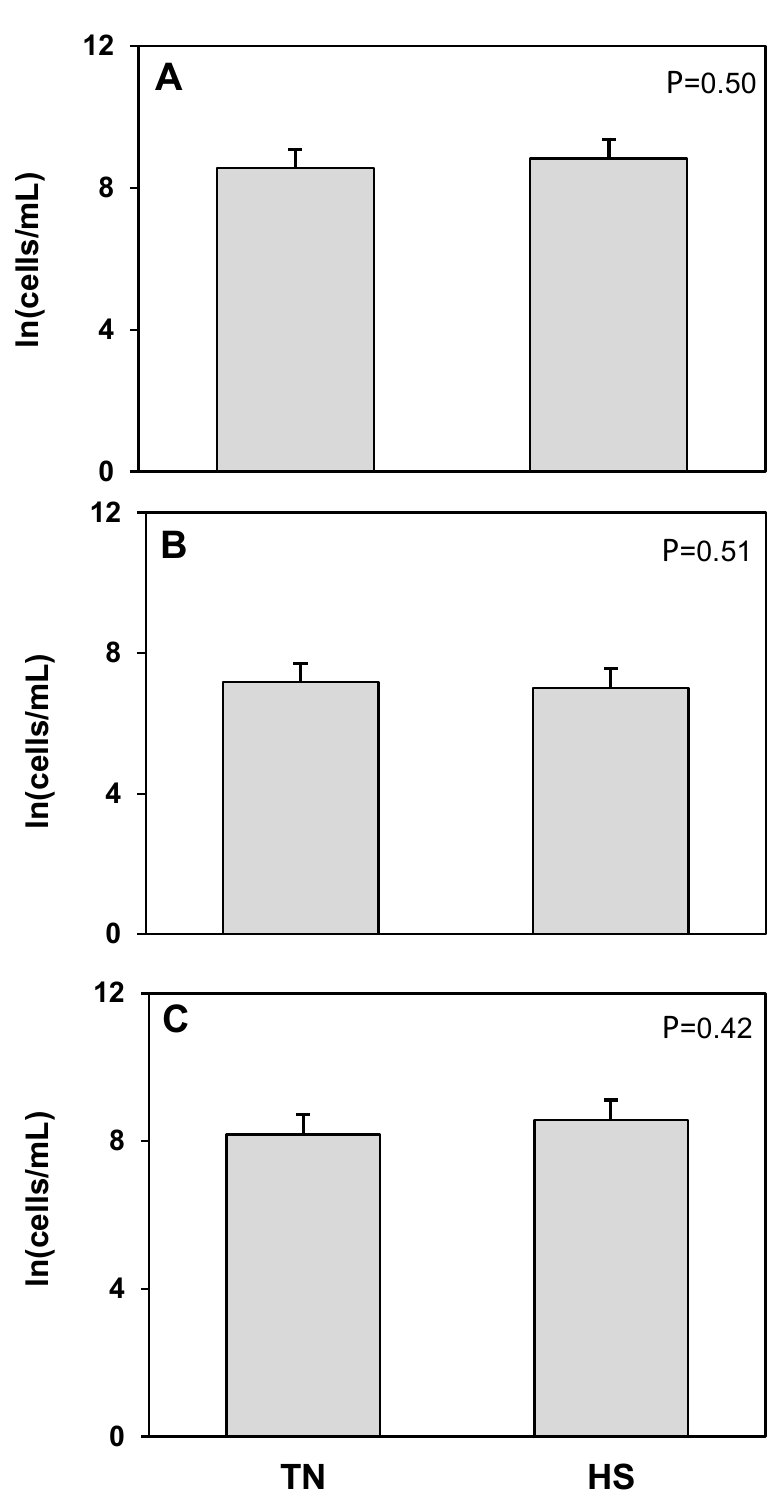
Figure 5. Heat stress (HS) impacts on monocyte/macrophage (CD14 + CD45 + ) cell concentration in milk compared to thermoneutral (TN) conditions. ( A ) Total cells, ( B ) live cells (propidium iodide negative; PI − ), and ( C ) dead cells (propidium iodide positive; PI + ). Cell population data were natural log transformed for statistical analysis. Values presented are least square means of natural log transformed data with error bars presenting the SEM (n = 10).